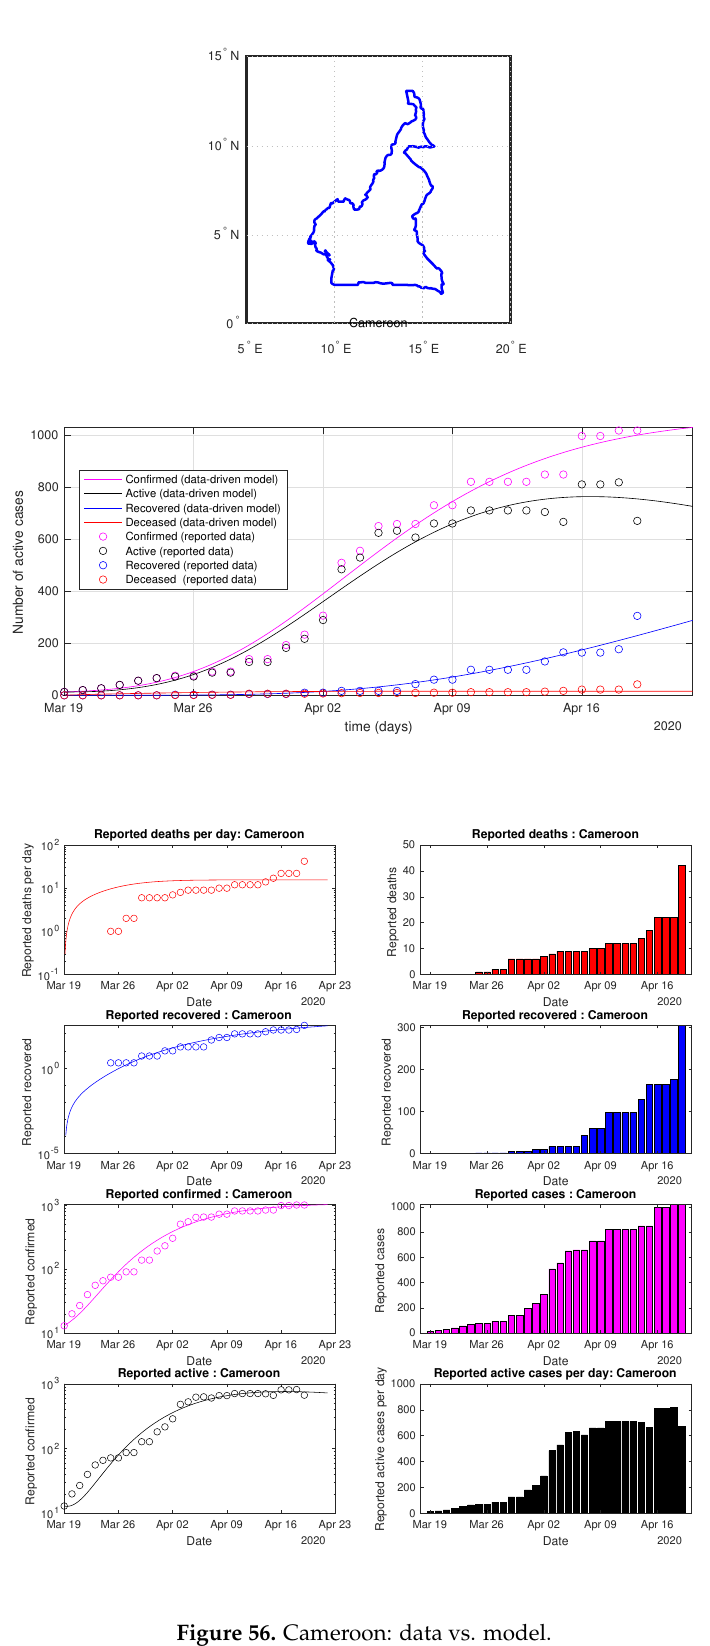
Figure 56. Cameroon: data vs.